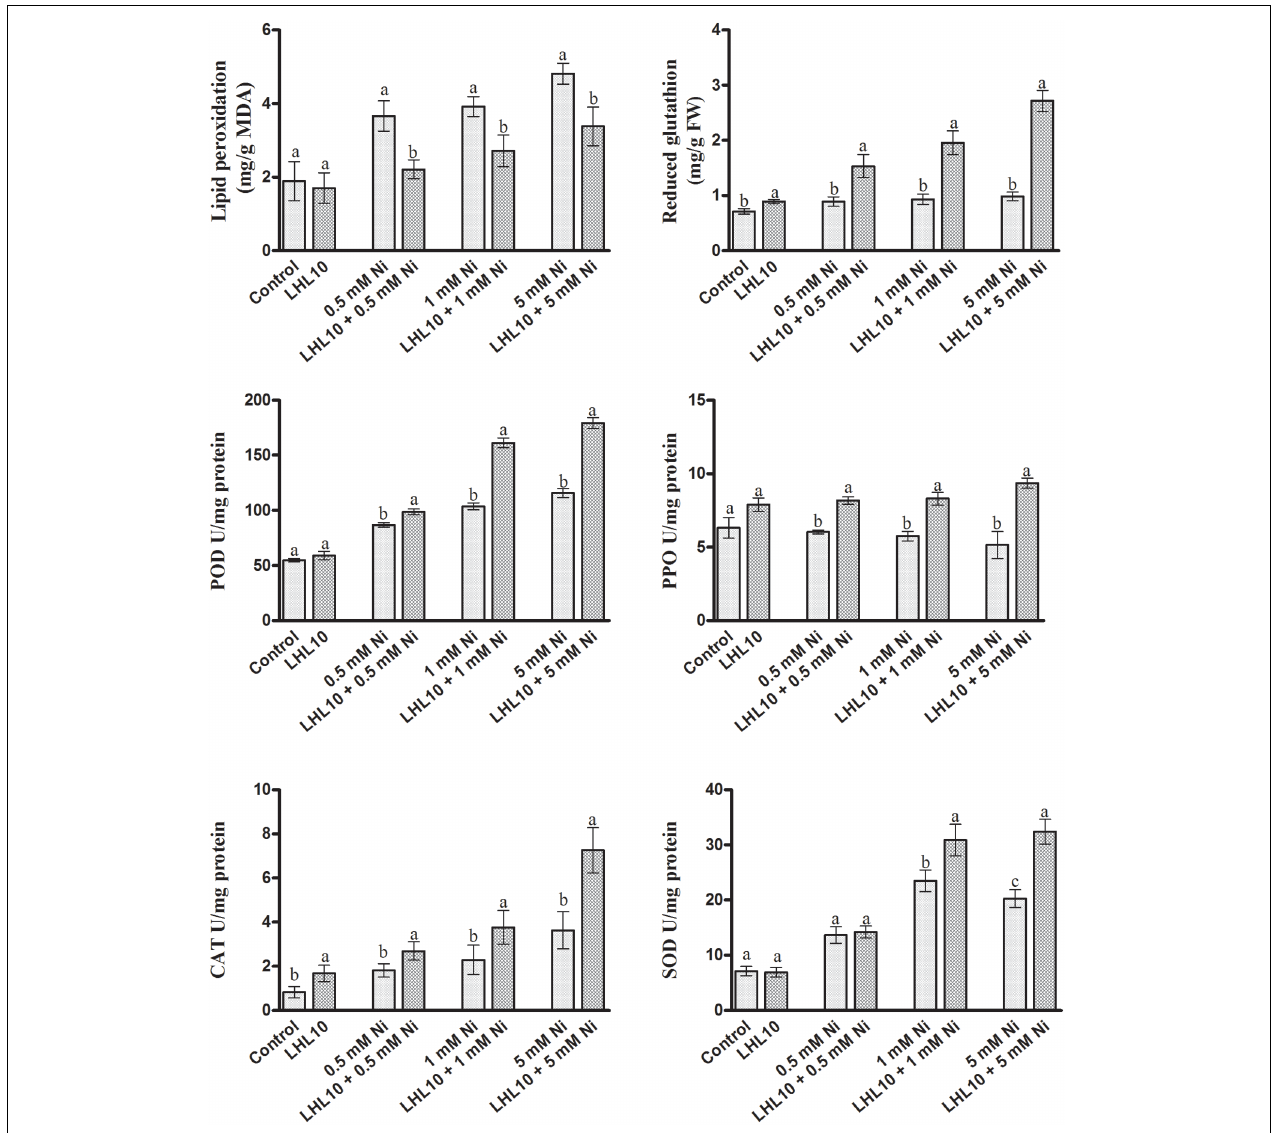
FIGURE 4 | Effect of LHL10 inoculation on MDA, GSH concentration and POD, PPO, SOD, and CAT activity in soybean shoots under different concentrations of Ni. Each value represents the mean ± standard error. Different letters on the bars represent significant differences between the treatments (Tukey’s HSD, p <